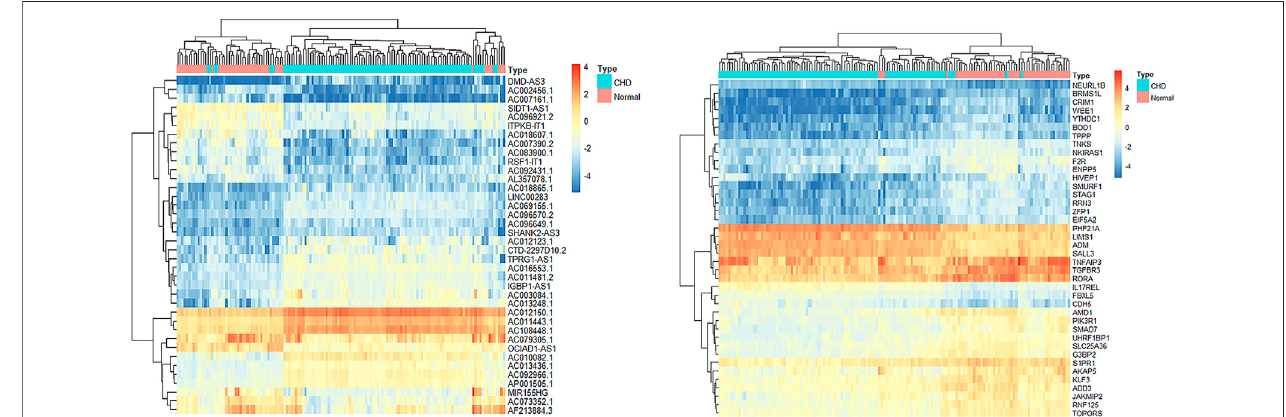
FIGURE 4 | Heatmaps of DElncRNAs and DEmRNAs.